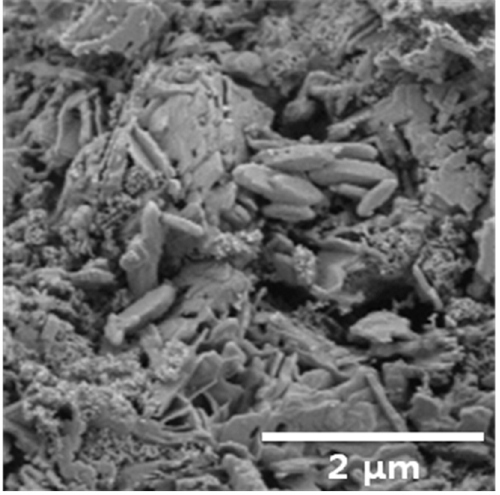
Figure 4. Scanning electron microscopy image of the Pt/BHA catalyst.